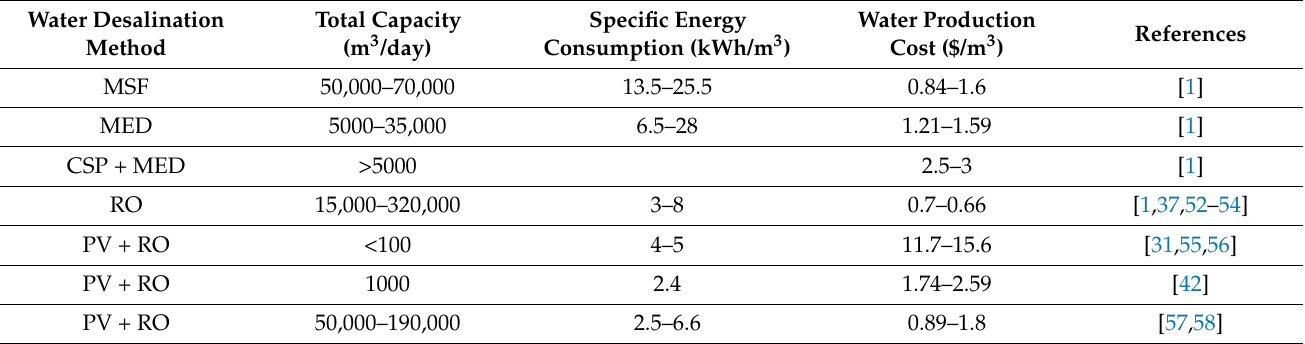
Table 2. A summary of economic aspects of thermal and membrane seawater desalination